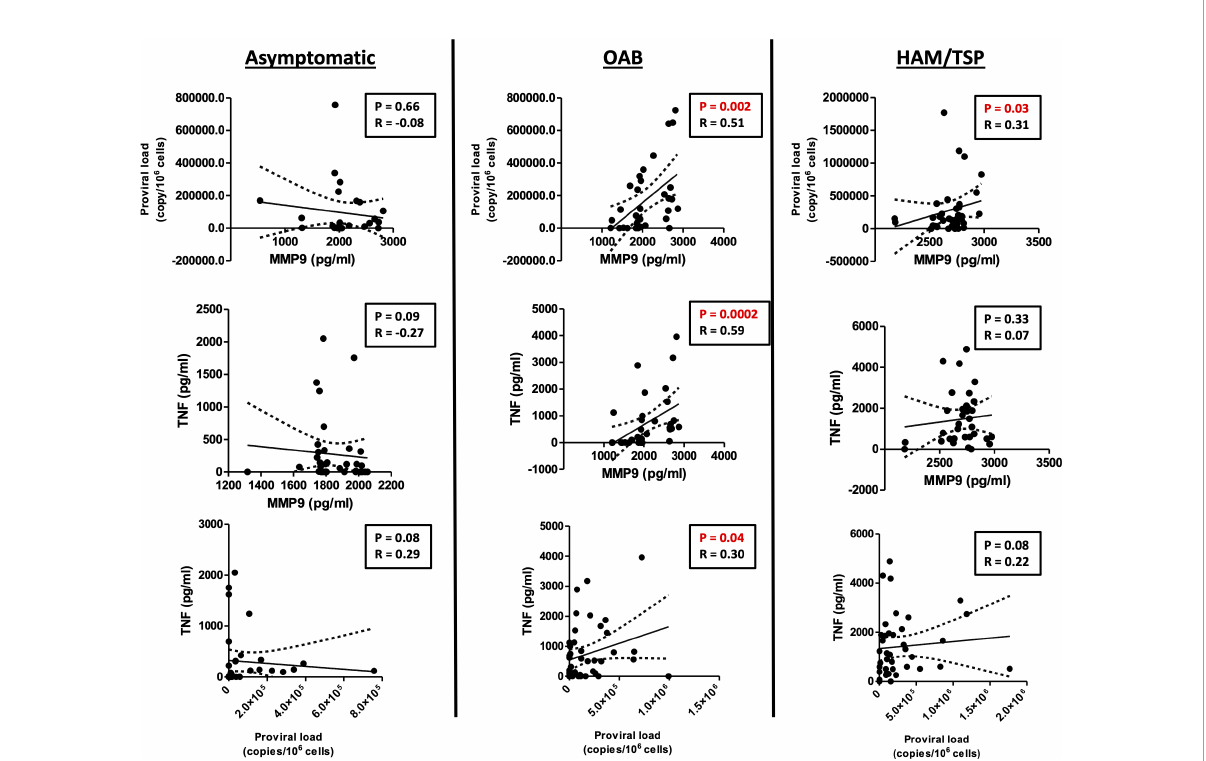
FIGURE 3 MMP-9 levels positively correlate with proviral load and TNF in OAB-HLTV-1-infected patients. Correlation between MMP-9 levels and proviral load, as well as TNF, in asymptomatic HTLV-1-infected individuals, OAB-HTLV-1-infected and HAM/TSP patients. Spearman ’ s correlation rank testing was used for